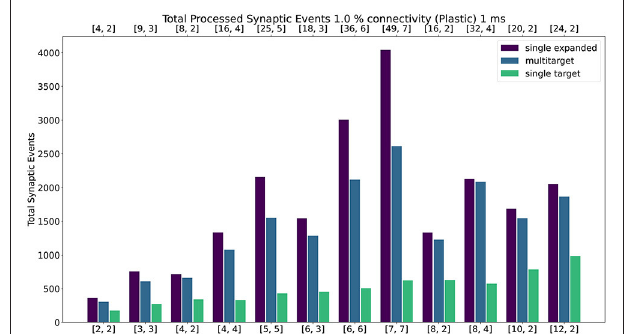
FIGURE 12 | Peak processed synaptic events per timestep. The presented configuration represents a 1% connectivity network with plastic connections. Timestep resolution is set to 1 ms. The plot shows results for the single target expanded (purple), multi-target (blue) and single target (green) cases. The horizontal axes show the number of cores per ensemble in the form of [[ S c , N c ]], as indicated in Section 4.2.1 and Figure 9 . The top axis refers to the single target expanded case (purple), the bottom to the other cases.